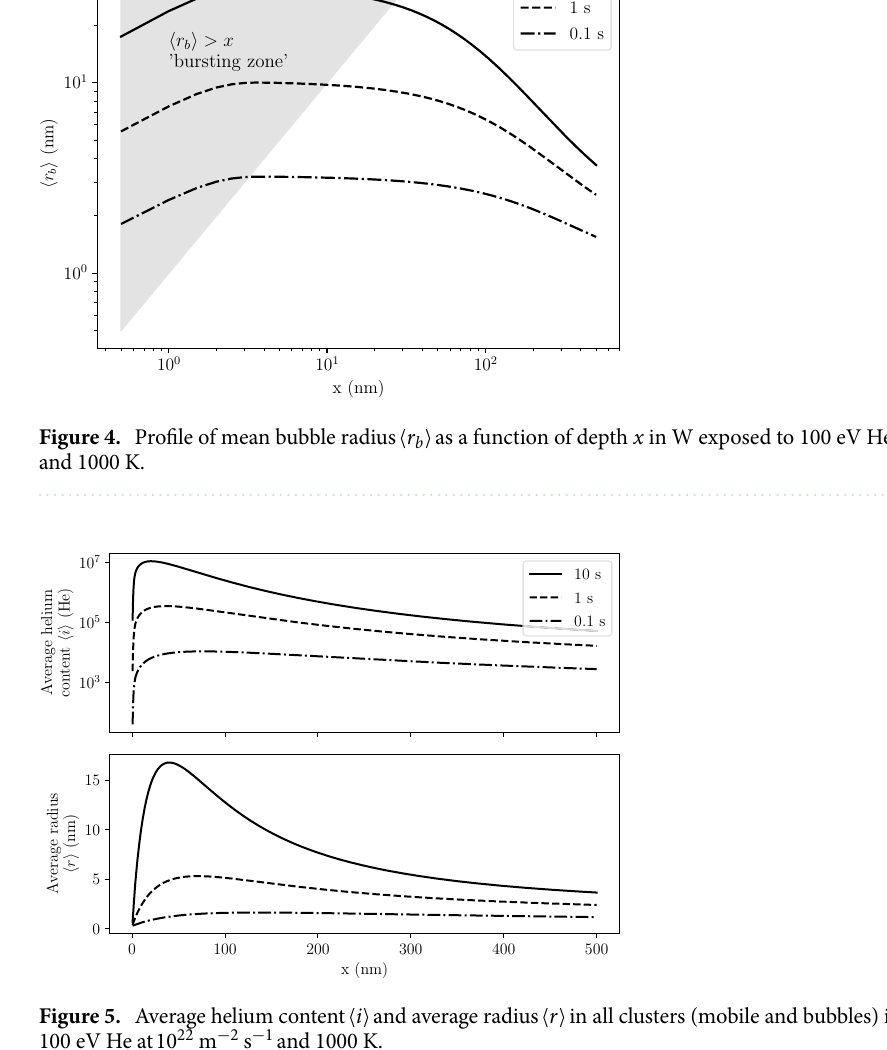
Figure 5. Average helium content 100 eV He at 10 22 m − 2 s − 1 and 1000